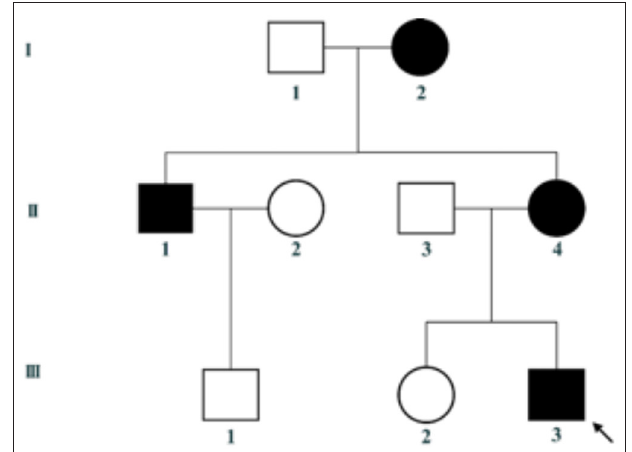
FIGURE 1 | Pedigree of the family. III-3 is the